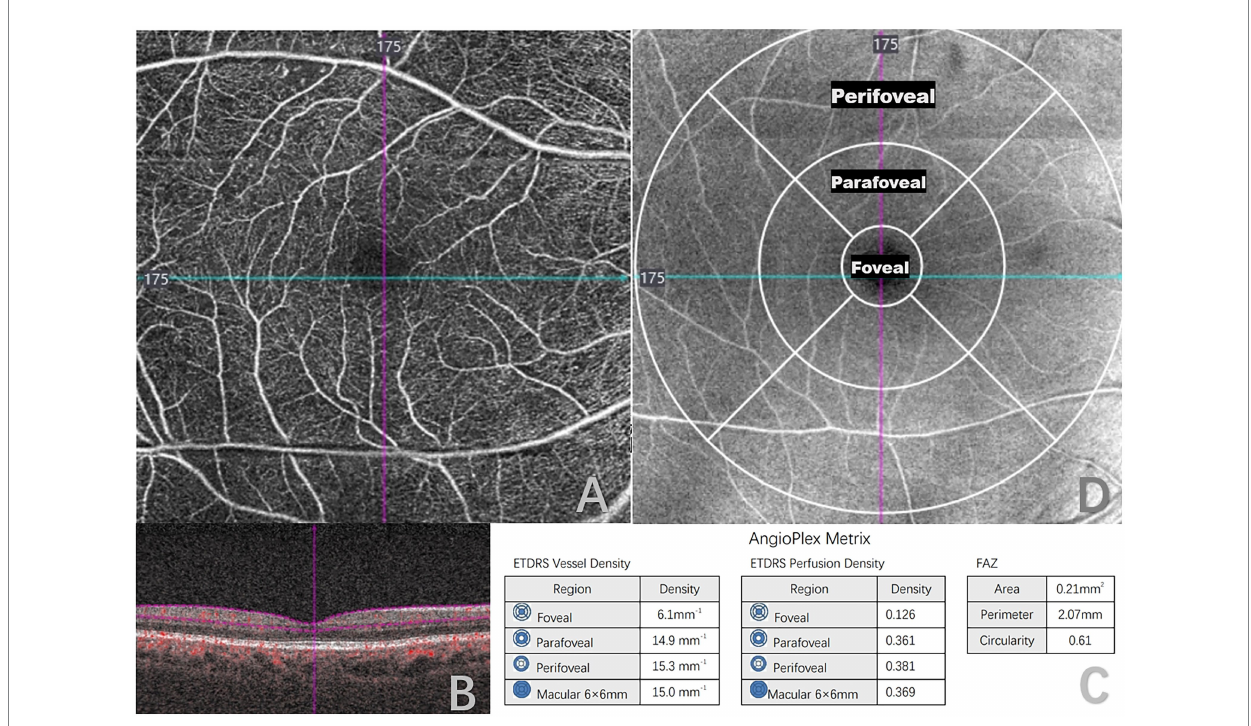
FIGURE 1 Quantitative measurement of optical coherence tomography angiography (OCTA) 6 × 6-mm scans in a type 2 diabetes mellitus (T2DM) patient. (A) 6 × 6-mm en face image of the superficial capillary plexus (SCP). (B) B-scans with flow encoding show the slab segmentation (horizontal purple lines), which included the SCP. (C) Angioplex metrics, including vessel density, perfusion density and foveal avascular zone (FAZ) parameters. (D) OCT en face image of the superficial layer overlaid with the early treatment of diabetic retinopathy study grid